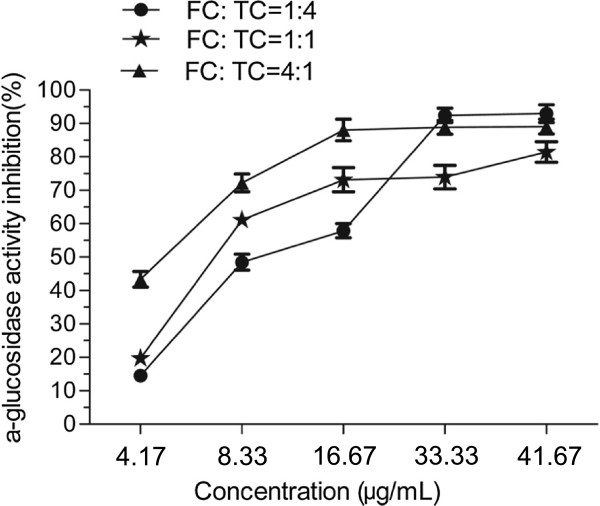
Inhibitory activities of the three complexes of flavonoid compound (FC) and triterpenoid compound (TC) with mass ratio of 4:1, 1:1 and 1:4 against α-glucosidase.